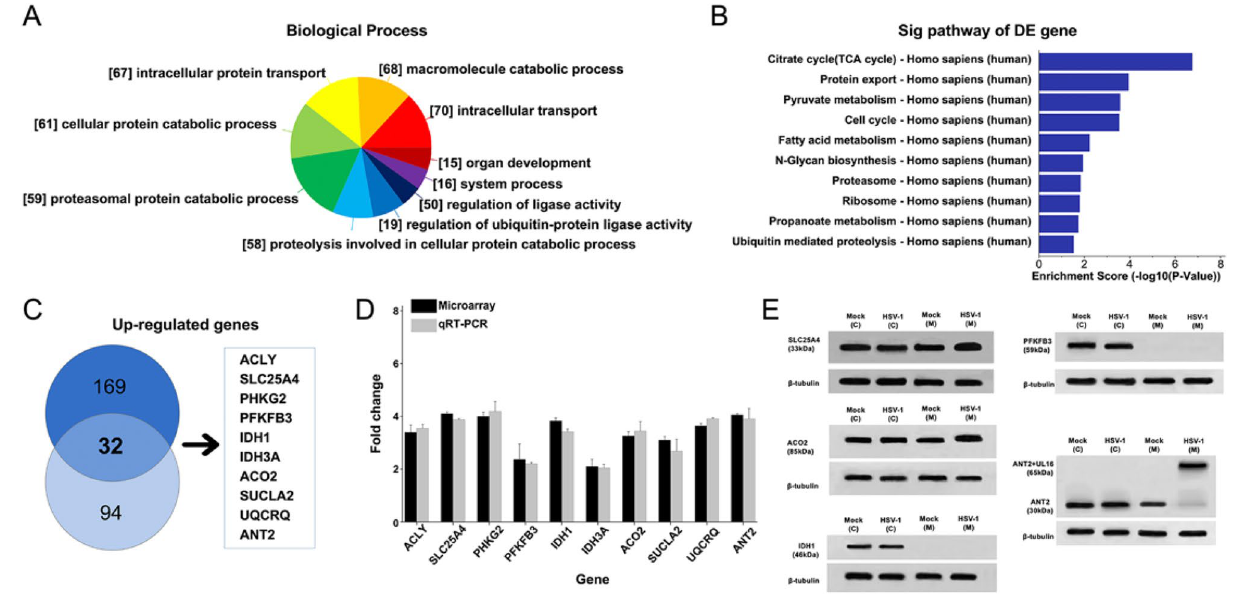
Figure 1. Microarray data analysis and validation of array data by quantitative real-time PCR. HUVEC cells were infected with HSV-1 at an MOI of 5. After 24 h post-infection, compared to Mock cells, the HSV-1 mutant infected cells revealed the differentially expressed genes, especially upregulated genes, were classified into different functional categories according to Gene Ontology annotation. DESeq 3.4.4 (https:// bioco nduct or. org/ packa ges/ relea se/ bioc/ html/ DESeq. html), Endeavour 3.71 (http:// homes. esat. kuleu ven. be/ ~bioiu ser/ endea vour/ endea vourw eb. php), ToppGene (http:// toppg ene. cchmc. org). ( A ) Upregulated genes were described by biological process. ( B ) The differentially expressed genes were also analysed by KEGG Pathway. The top ten enrichment scores of upregulated pathways in HSV-1 infected cells. ( C ) Through the screening of differentially expressed genes in multiples of 2 times or more than 2 times, Venn diagram of the significantly upregulated genes in HSV-1 infected cells compared with Mock cells. ( D ) The qRT-PCR data were normalized to β-actin expression. Fold changes were determined by calculating the ratio of the mean expression values from the control and samples. Each value represents the mean of triplicates and barsindicate standard deviation. ( E ) Western blot of HSV-1 infected cells at 24 h, the differentially expressed proteins in cytoplasm and mitochondria. Mock as control group (empty plasmid transfection) (ImageQuant 350